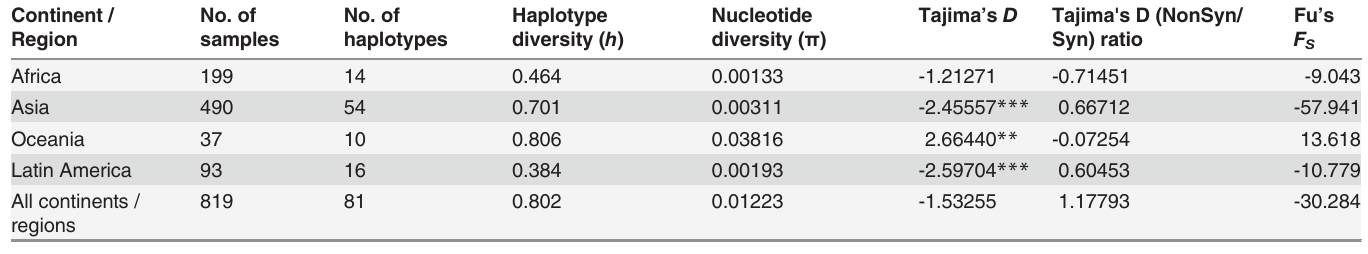
Table 3. List of number of samples studied, number of haplotypes, haplotype diversity ( h ), nucleotide diversity ( π ), Tajima ’ s D and Fu ’ s F S tests for Maruca vitrata populations from four selected continents / regions. Continent / No. of Region